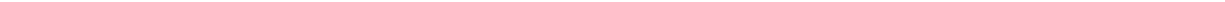
Fig. 7 Ad-miR-327 inhibits WAT browning. a Histological analysis of GFP + cells in scWAT transfected with a control adenovirus (Ad-miR-NC) or an adenovirus expressing miR-327 (Ad-miR-327). Perilipin (PERI) was used to identify adipose tissues. Arrows point to GFP + cells. b qPCR analysis of miR- 327 expression in Ad-miR-327 compared to Ad-miR-NC. Sno-202 served as an internal control ( n = 6 samples per group). c , g Histological analysis of adipocyte morphology (H&E), adipocytes (PERI), mitochondria (COX4) and uncoupling protein 1 (UCP1) in c 5-day CL-316243-treated scWAT compared to vehicle-treated control. g Two-week 4 °C-treated scWAT compared to 30 °C control. Double-headed arrows mark adipocyte diameter. Arrows point to respective positive signals. d – f , h – j Quanti fi cations of adipocyte size and positive signals of COX4 and UCP1 in d – f CL-316243- and vehicle-, and h – j 30 °C- and 4 °C-treated scWATs ( > 30 adipocytes per fi eld; n = 10 random fi elds; n = 6 mice per group). Immunode fi cient NSG mice were used for all experiments in this fi gure. Scale bars, 100 μ m. NS, not signi fi cant. * P < 0.05, ** P < 0.01, and *** P < 0.001 by Student ’ s t -test. Data presented as mean ±